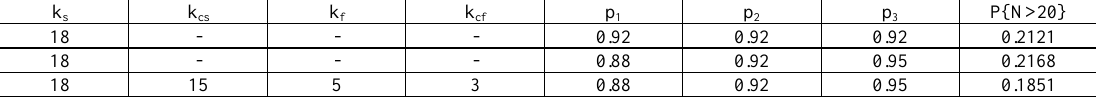
Table 7. P{N>20} for a two change points system, TSCSTFCF n 1 =5, n 2 =9, n 3